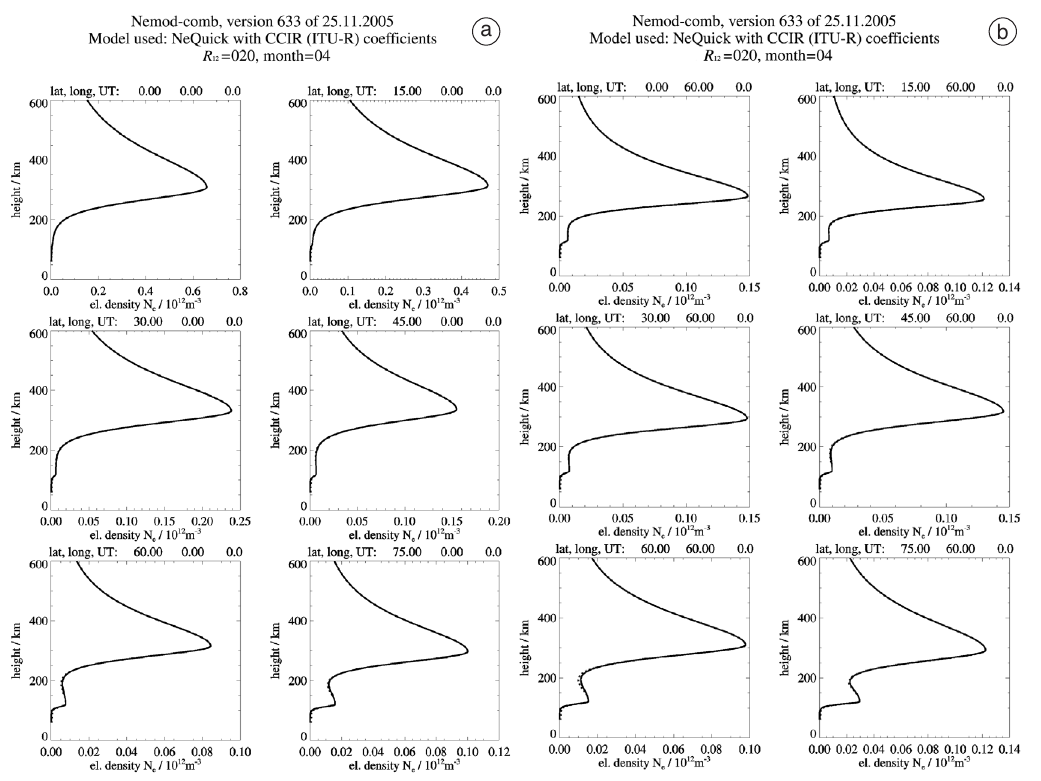
Fig. 4a,b. Height profiles of electron density: April; R 12 = 20; 0 h UT; geografic longitude 0°E (a), 60°E (b); 0 h LT (a), 4 h LT (b); geografic latitudes 0°N ( top left ) to 75°N ( bottom right ); latitude spacing 15°. Solid curves: revised NeQuick, dotted curves: NeQuick, old